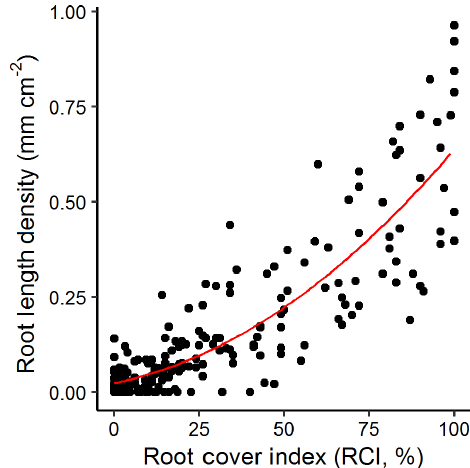
Figure 3. Root cover index (RCI) against root length density (RLD) for a random sample of images ( n = 300) from three imaging cam- paigns at our site. A third-order polynomial (indicated) fit to these data with an R 2 of 0.77 was used to predict RLD for all other fig-